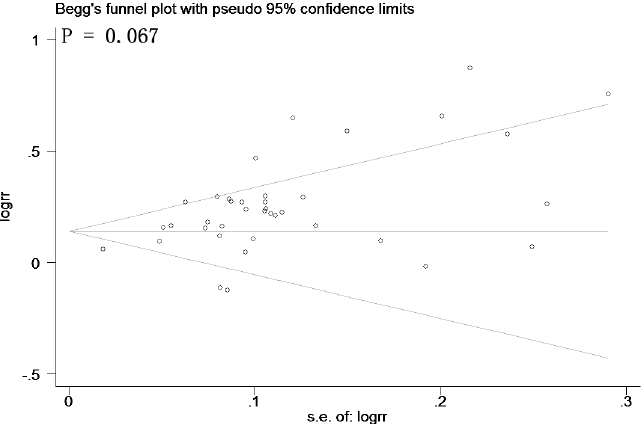
Fig 3. Begg ’ s funnel plot for the association between APOA5 rs662799 and CHD * . * Horizontal axis represents the standard error of log rr. Vertical axis represents the log rr. The s.e. denotes standard error.